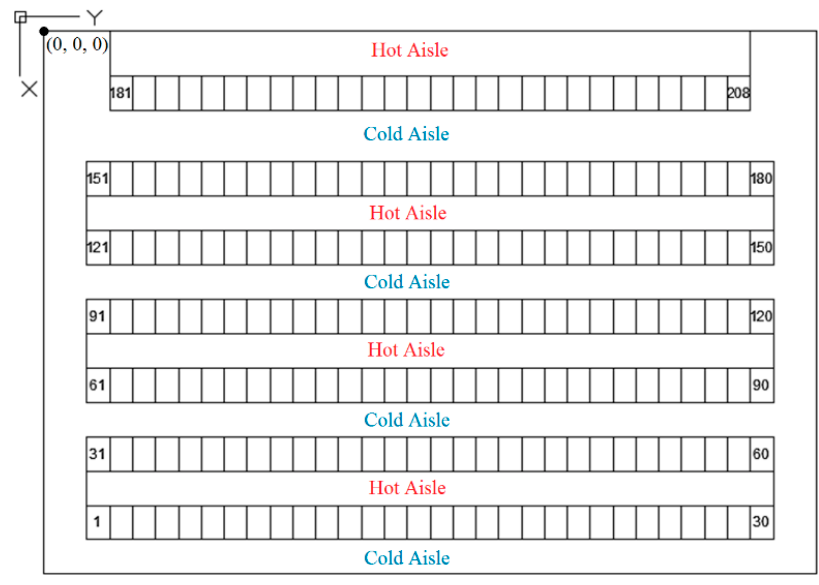
Figure 3. The representation of upper plan view of the data center room.